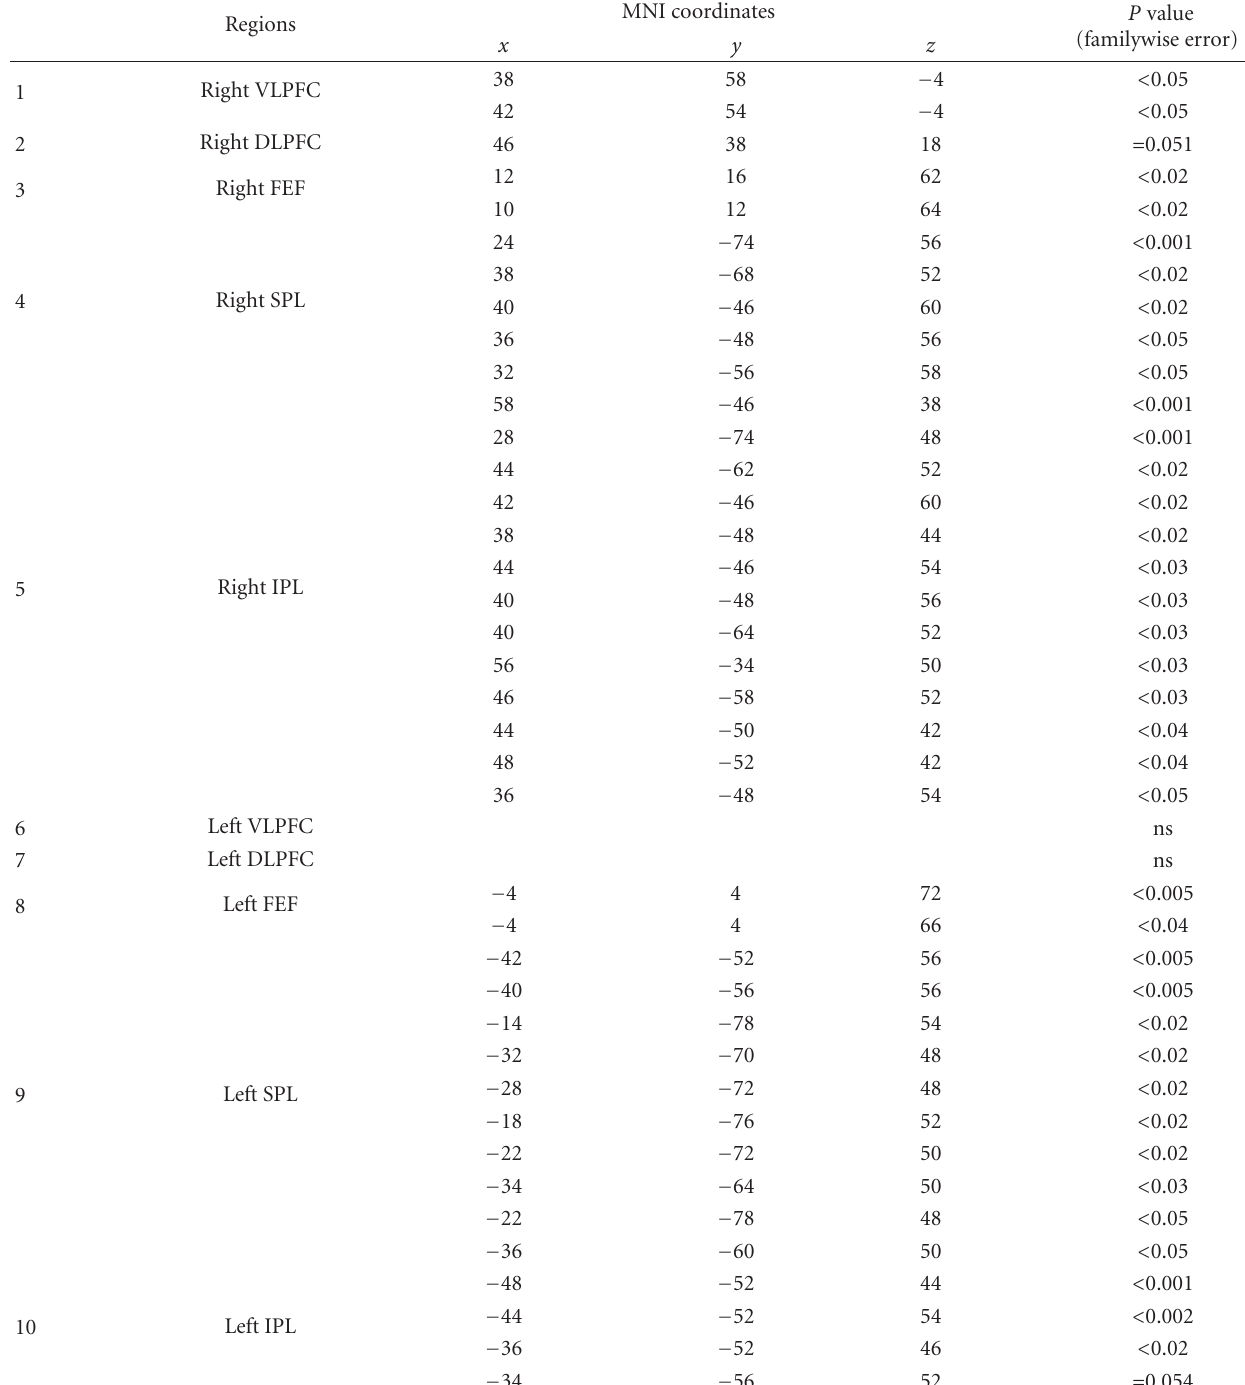
Table 1: Small volume correction results based on contrast of the Directional task versus the Nondirectional task. The x , y , and z coordinates are from SPM5. SPL: superior parietal lobe, IPL: inferior parietal lobe, FEF: frontal eye field, DLPFC: dorsolateral prefrontal cortex; VLPFC: ventrolateral prefrontal cortex, R: right hemisphere, L: left hemisphere, M: bilateral